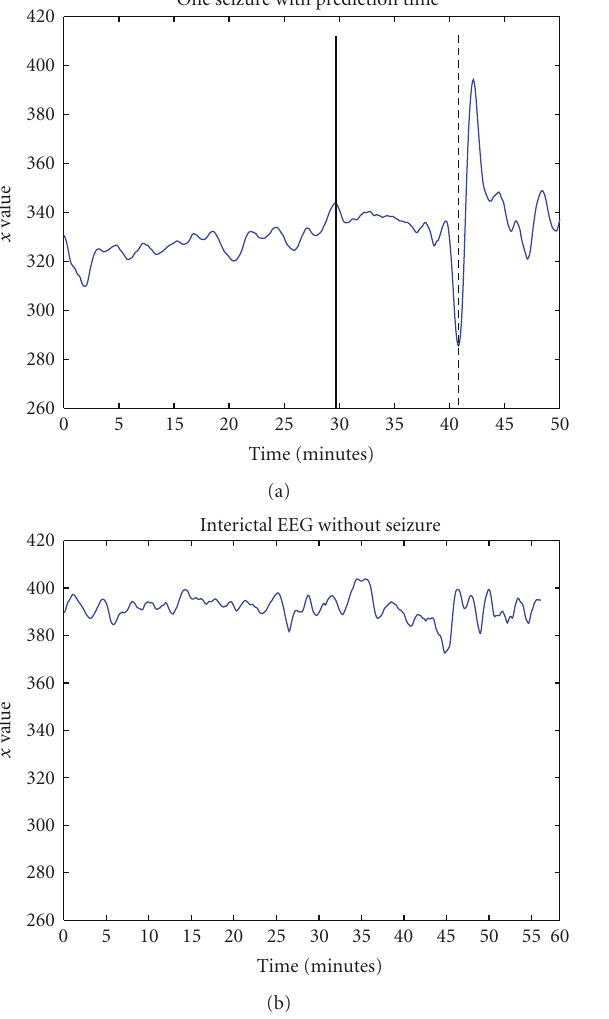
Figure 4: Ictal and interictal hidden variable x from one patient with epilepsy. The vertical solid line marks prediction time point and the vertical dashed line indicates seizure